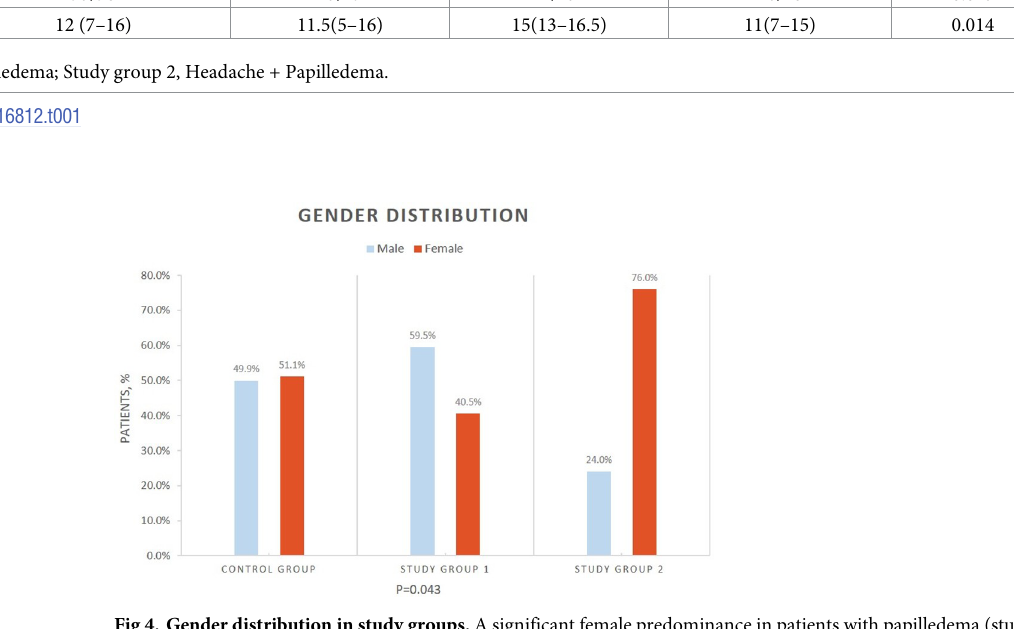
The control group had a median ONSD/ETD index value of 0.17 (IQR = 0.15–0.18), study group 1 (patients with no signs of papilledema) had a median ONSD/ETD index value of 0.18 (IQR = 0.16–0.19), and study group 2 (patients with papilledema) had a median ONSD/ETD index value of 0.24 (IQR = 0.22–0.25). ONSD/ETD index was found to have significantly higher values (p < 0.001) in study group 2 (patients with papilledema) compared to study group 1 (patients with no signs of papilledema) and the control group (Table 2). No correla- tion between ONSD/ETD index values and age was found (r = -0.086, p = 0.288). There was no significant difference in mean ONSD/ETD value comparing study group 1 and the control group (p = 0.052). Statistically significant differences were found when com- paring study group 1 (no papilledema) and study group 2 (p < 0.001) and between the control group and study group 2 (p < 0.001) (Fig 5). An excellent Interobserverve agreement was observed (ICC range between 0.86–0.98).